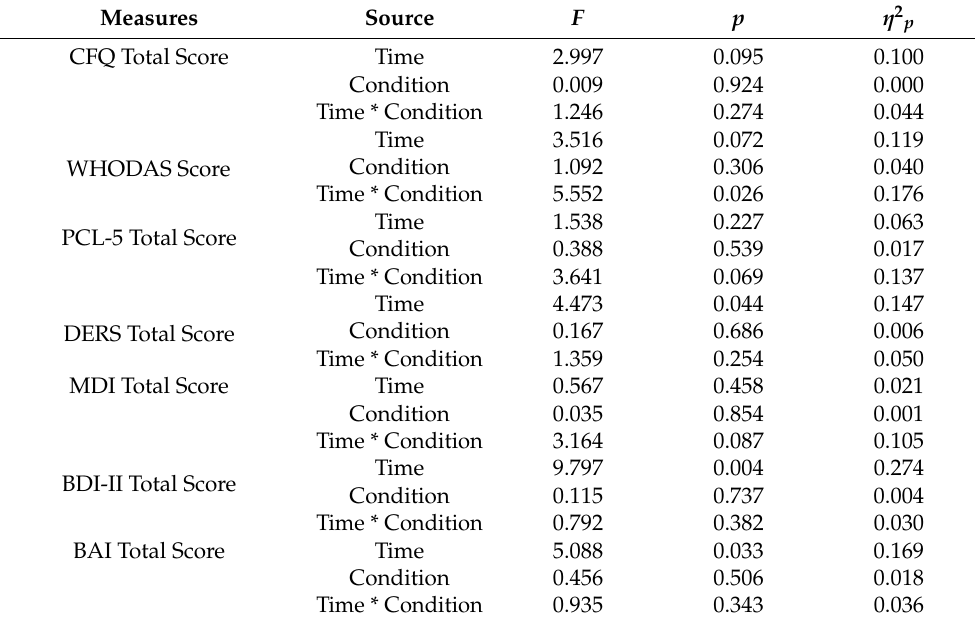
Table 5. The 2 × 2 ANOVA tables for the subjective cognition, functioning, and self-report symptom